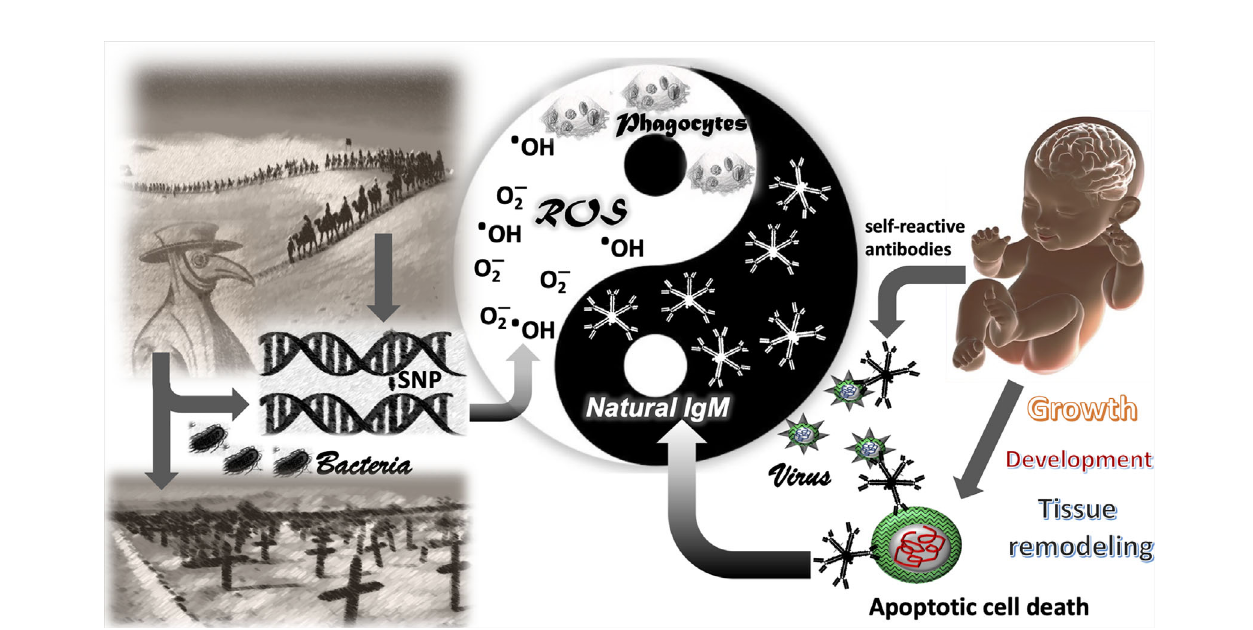
FIGURE 1 | The Yang-Yin of immune defense. The genetic traits favoring the defense against bacterial pathogens in the past (ROS and IgM) appeared to be vulnerable for COVID-19 – related mortality in the 21th century. The left side demonstrates how bacterial pathogens shaped the genome in human populations by selective survival of individuals with single nucleotide polymorphisms (SNPs) in genes facilitating bacterial defense, such as the generation of reactive oxygen species (ROS) in phagocytes. The right side shows a newborn with the inherent high polyclonality of its natural IgM. Natural IgM recognize altered self-antigens and are important for removal of apoptotic cells in the developing neonate. Altered self-antigens are also present in the viral envelope of corona viridae. Such as natural IgM removes apoptotic cells in absence of in fl ammation, the virus is neutralized without in fl ammatory symptoms and disease. Reactive oxygen species represent the in fl ammatory and anti-bacterial part of immune defense, associated with Yang in traditional Chinese medicine (TCM). The natural IgM represents the anti- in fl ammatory and self-recognizing part of immune system involved in tissue remodeling, associated with Yin in